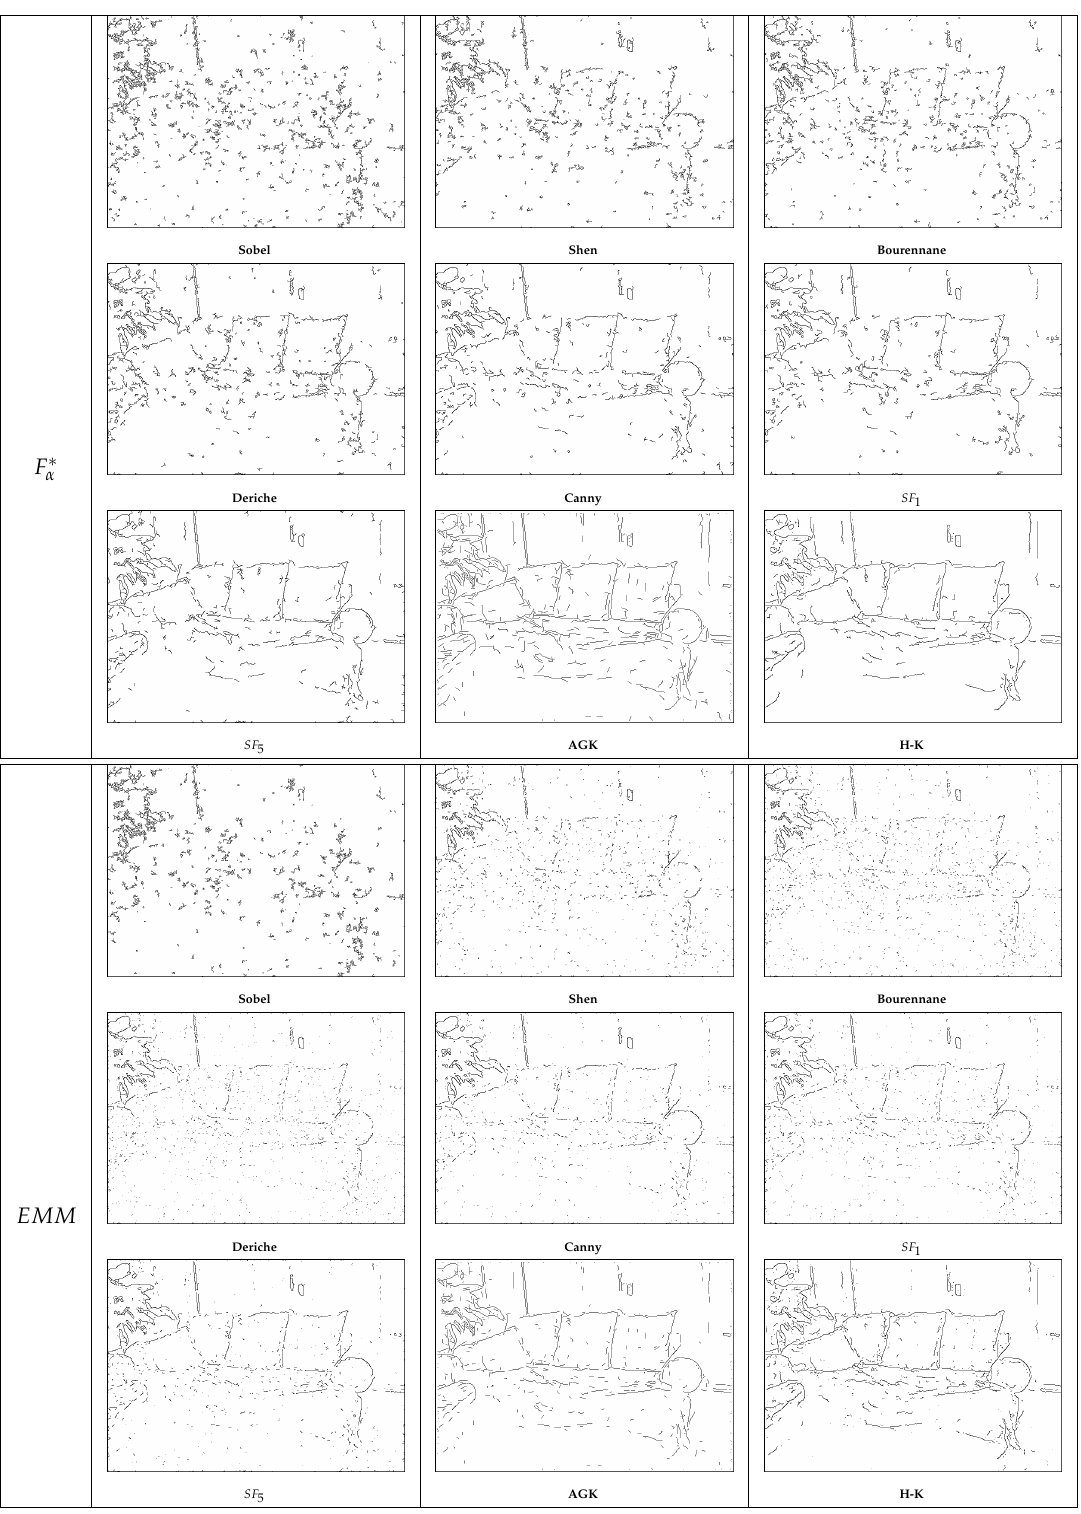
Figure 23. Ideal segmentations for several edge detectors on image 109, PSNR = 14